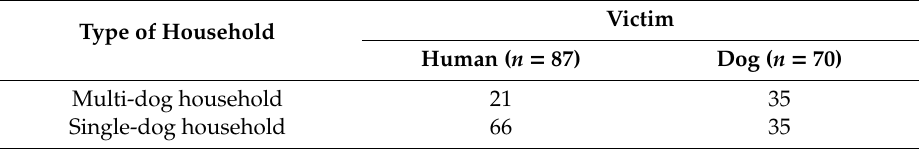
Table 23. Comparisons between dogs housed in multi- or single-dog households and the type of victim.